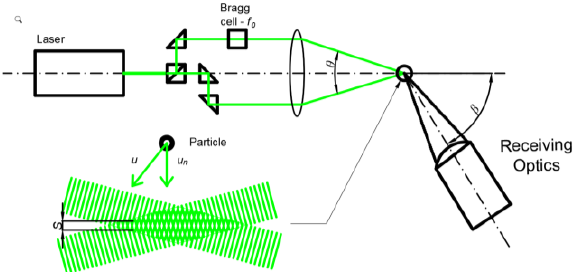
Fig. 1 The principle of the PDA: optical configuration of the system, fringe pattern formed by two coherent laser beams crossing with the